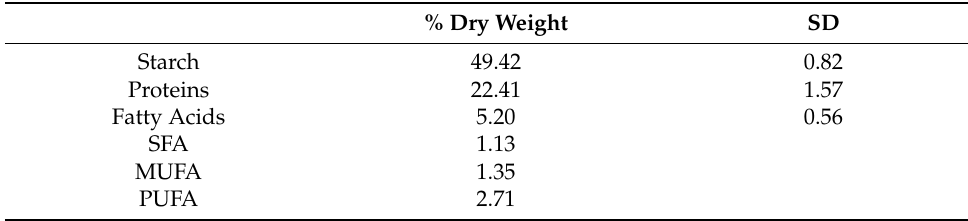
Table 2. Composition of starch-rich T. chui